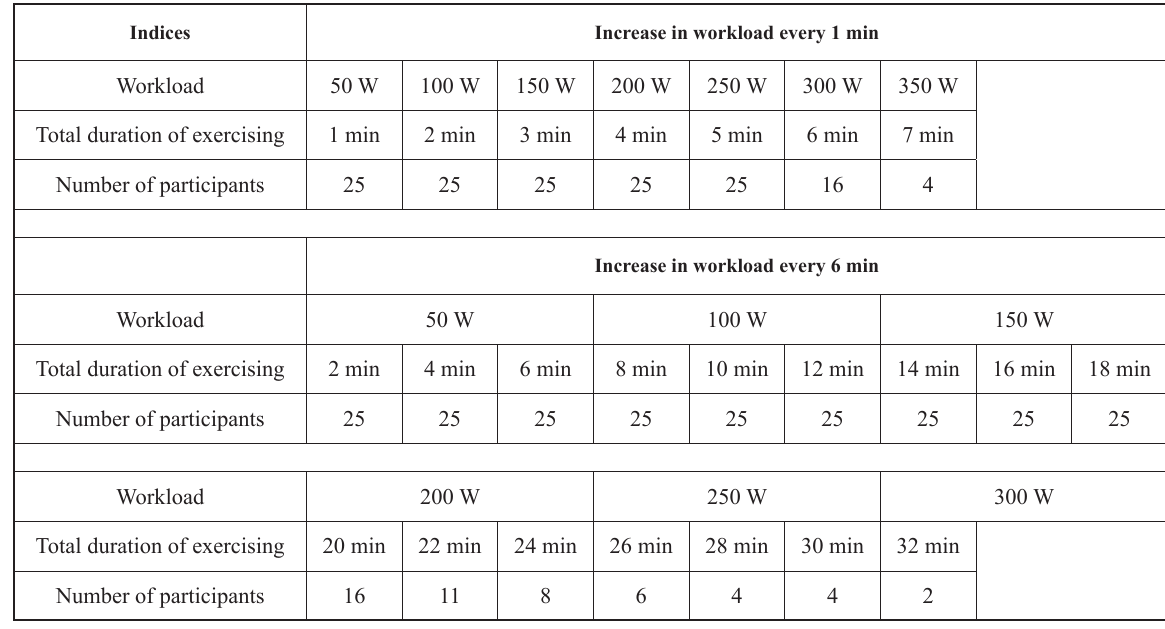
Table 1. Working capacity while two different protocols for increase in workload was applied